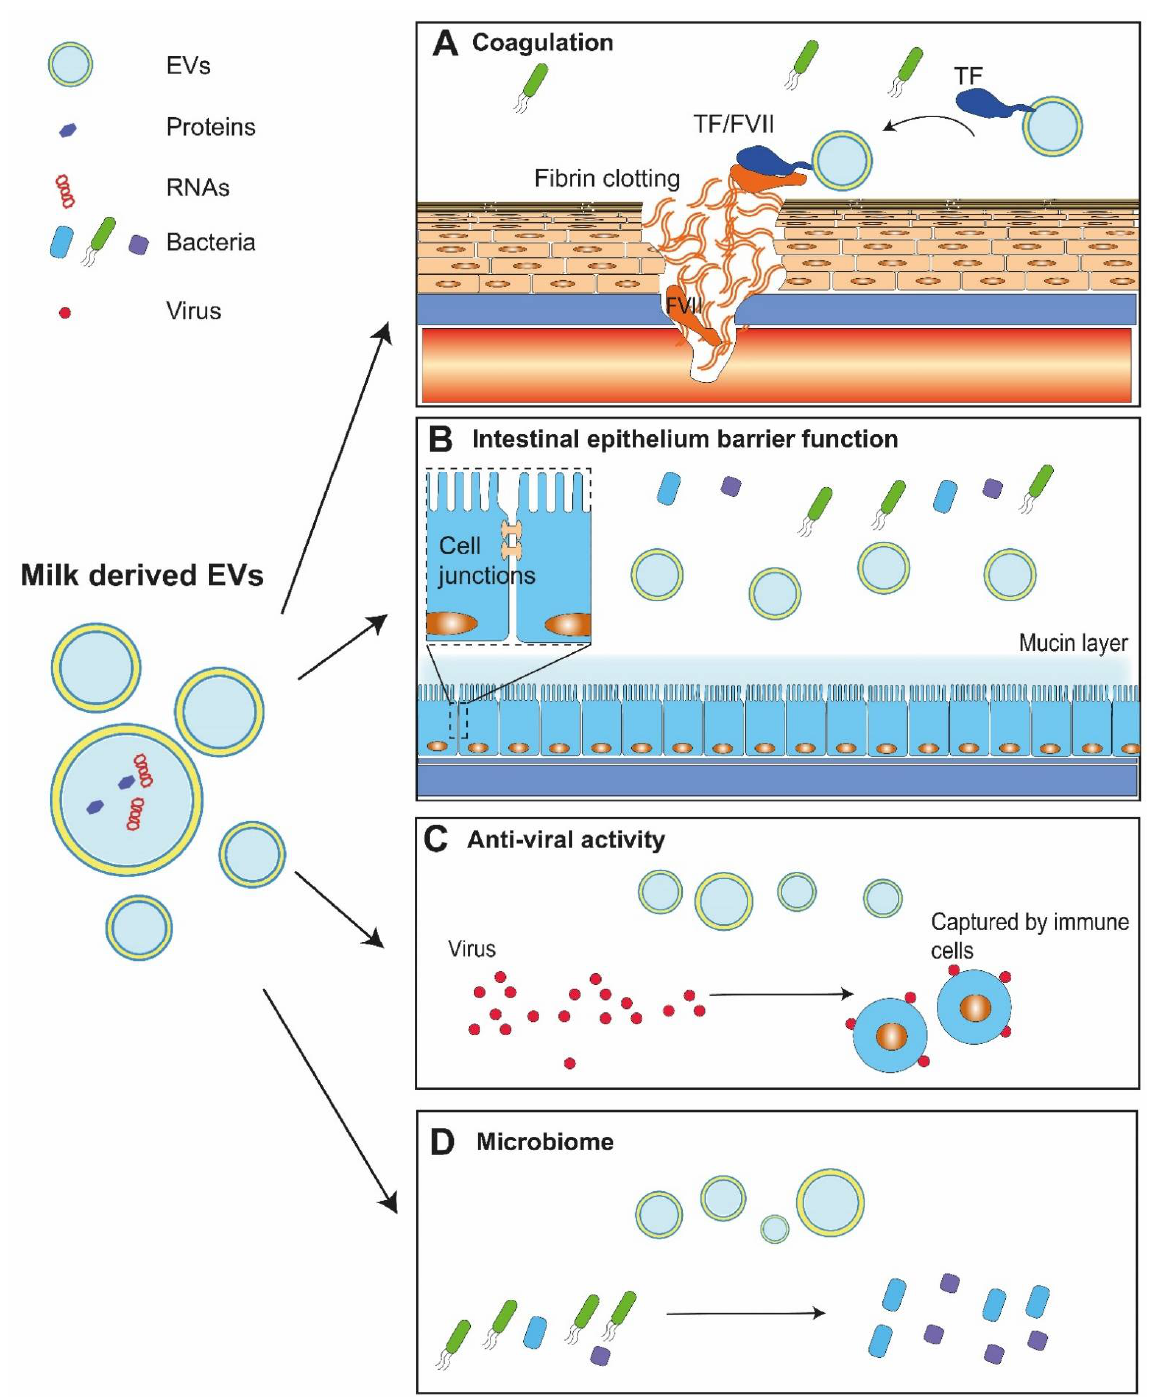
Figure 2. Functions of milk-derived extracellular vesicles. Milk contains extracellular vesicles (EVs). ( A ) EVs in human milk expose tissue factor (TF), the protein that triggers blood clotting by binding and activating factor VII (FVII), thereby promoting haemostasis and wound healing. ( B ) Milk EVs may survive the gastrointestinal conditions of newborns, and such EVs are thought to participate in immune responses and homeostasis of the gastrointestinal tract. ( C ) Milk EVs attenuate virus infection with help from immune cells. ( D ) Milk EVs may kill harmful bacteria and promote the growth of beneficial bacteria within the gastrointestinal tract, which may have beneficial effects on growth and development of the